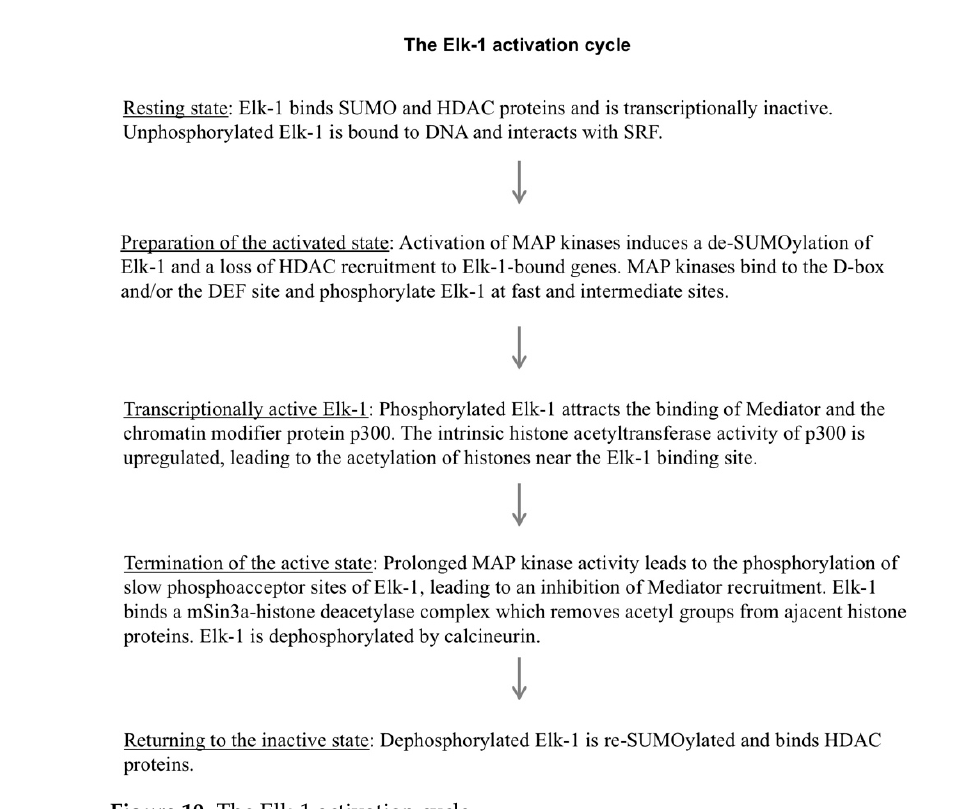
Figure 10. The Elk-1 activation cycle.